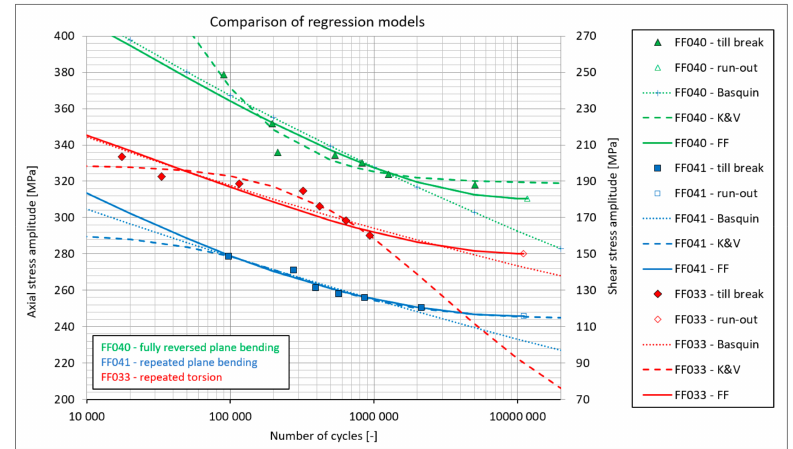
Figure 6. Comparison of the three approximation models for three different load